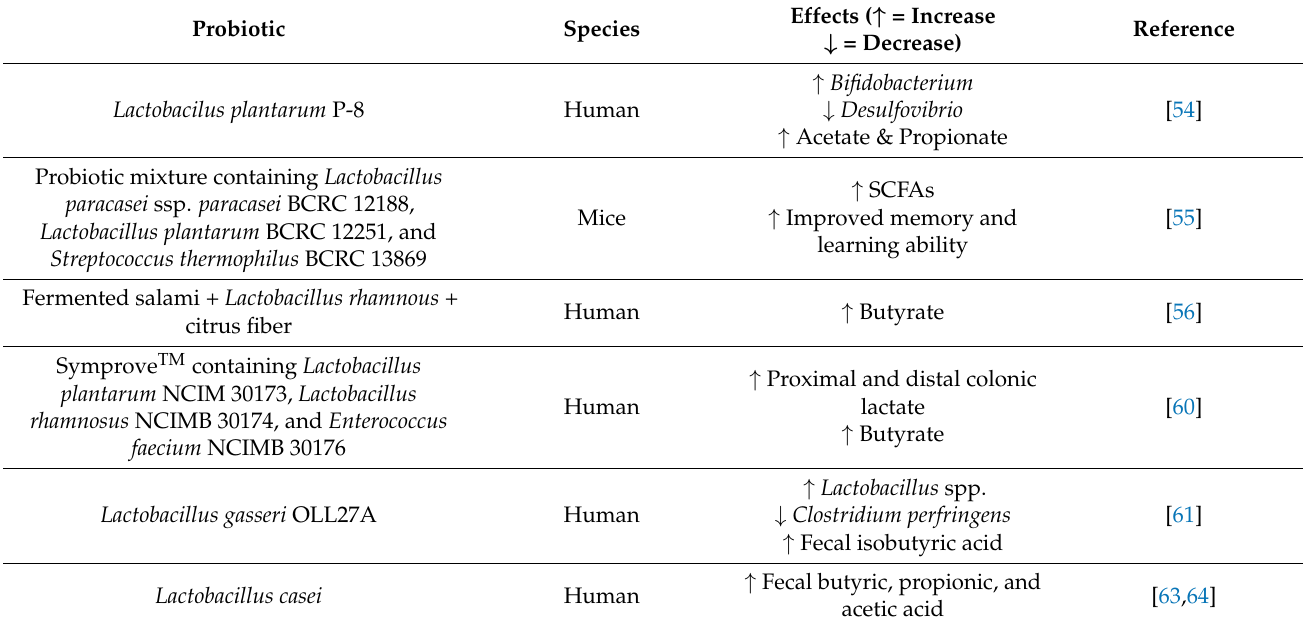
Table 1. The effect of probiotics on SCFA